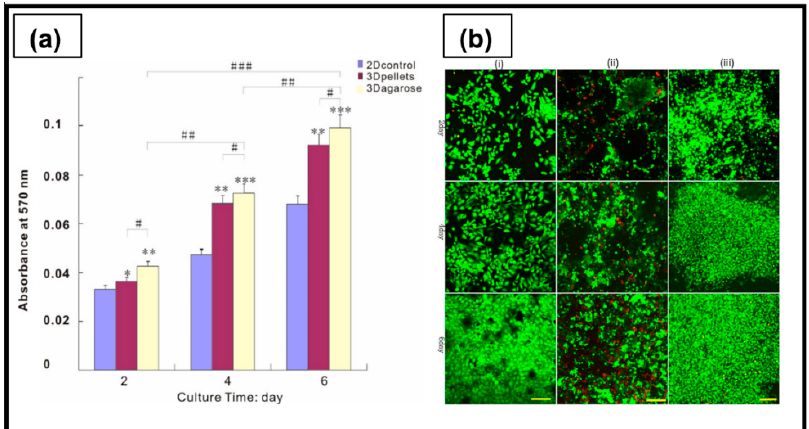
Figure 10. Agarose hydrogel. ( a ) SKOV3 cell proliferation in 3D and 2D cultures. */#, **/##, and ***/### denote p < 0.05, p < 0.01, and p < 0.001, respectively. ( b ) Live/dead cell assay: (i) 2D control, (ii) 3D control, and (iii) 3D agarose. Scale bar is 100 µ m